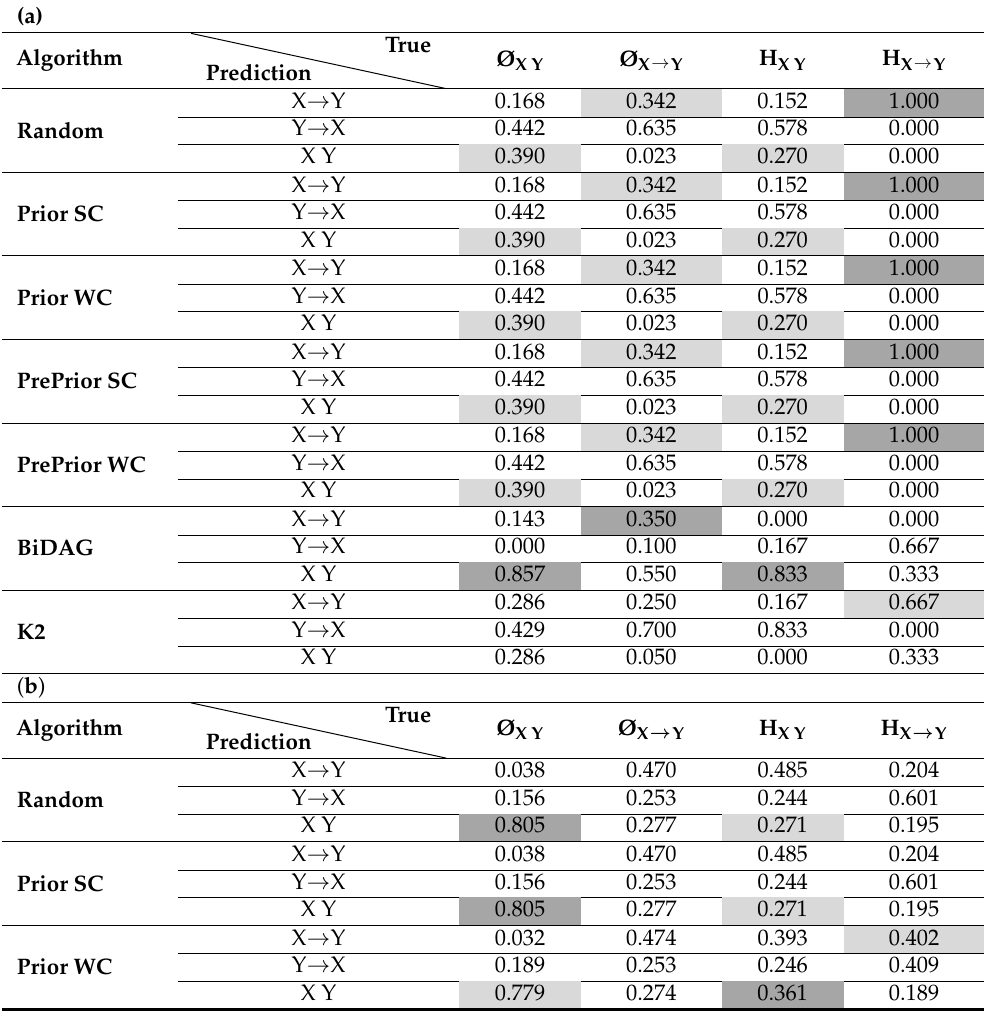
Table 8. Algorithms’ predicted probabilities of four causal pairwise relationships without the order weight. (a) Dataset for Sparse 9 variable with 50 cases (D50S9). Dark shaded cells represent the best prediction of the correct causal relationship; Bright shaded cells represent the second best prediction of the correct causal relationship. (b) Dataset for Close 9 variable with 50 cases (D50C9). Dark shaded cells represent the best prediction of the correct causal relationship; Bright shaded cells represent the second best prediction of the correct causal relationship. (c) Dataset for Sparse 9 variable with 1000 cases (D1KS9). Dark shaded cells represent the best prediction of the correct causal relationship; Bright shaded cells represent the second best prediction of the correct causal relationship. (d) Dataset for Close 9 variable with 1000 cases (D1KC9). Dark shaded cells represent the best prediction of the correct causal relationship; Bright shaded cells represent the second best prediction of the correct causal